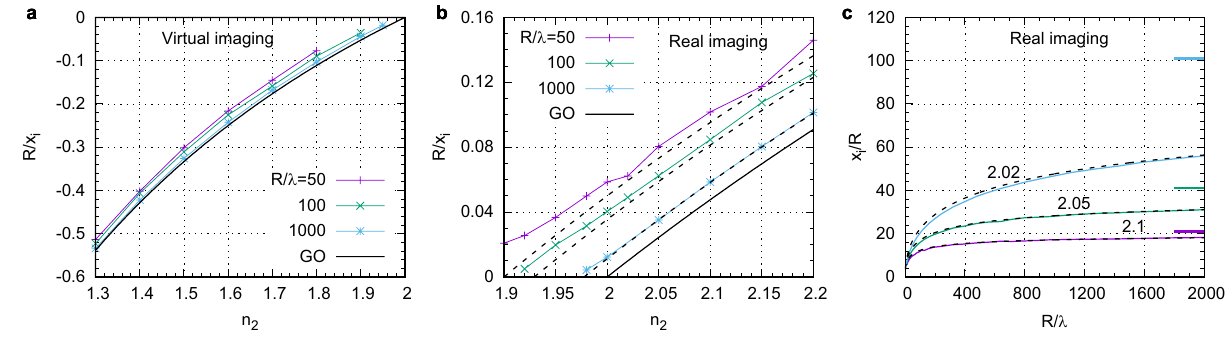
Figure 5. Dependence of the image plane position x i , which is defined by the maximum of psf ( x , 0 ) , on n 2 and R / (cid:31) . The corresponding magnification is M x i / R . ( a,b ) Inverse of x i as a function of n 2 for several R / (cid:31) . The = − dashed lines running next to the solid lines in ( b ) are the corresponding analytical results given by Eq. (10). ( c ) x i / R as a function of R / (cid:31) for several n 2 indicated near the curves. The horizontal lines on the right side show the corresponding GO values of M given by Eq. (2). The dashed black lines show the analytical results described by Eq.